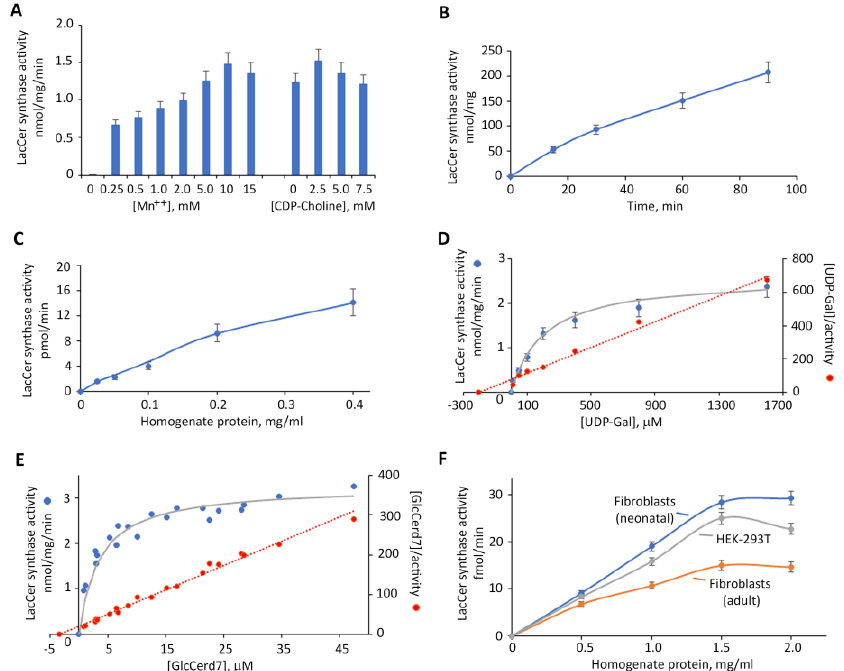
Figure 7. Characterization of LacCer synthase activity detected with GlcCerd7 and LC-MS/MS. Dependence of the activity expressed in HEK-B4GALT5 on the concentration of Mn ++ or CDP-Choline (Panel ( A )). Activity measured in HEK-B4GALT5 after different times of incubation (Panel ( B )) or using different amounts of homogenate protein (Panel ( C )). Dependence of the activity expressed in HEK-B4GALT5 on the concentration of the donor substrate UDP-Gal at fixed saturating concentration of GlcCerd7 (10 µ M). The Hanes–Woolf plot of activity values, presented in red (secondary axis), was used for calculating kinetic constants (Panel ( D )). Dependence of the activity expressed in HEK-B4GALT5 on the concentration of the acceptor substrate GlcCerd7 at a fixed saturating concentration of UDP-Glc (0.6 mM). The Hanes–Woolf plot is shown in Panel D (Panel ( E )). The reactions reported in Panels D and E were obtained by incubating 0.5 µ g of HEK-B4GALT5 homogenate protein